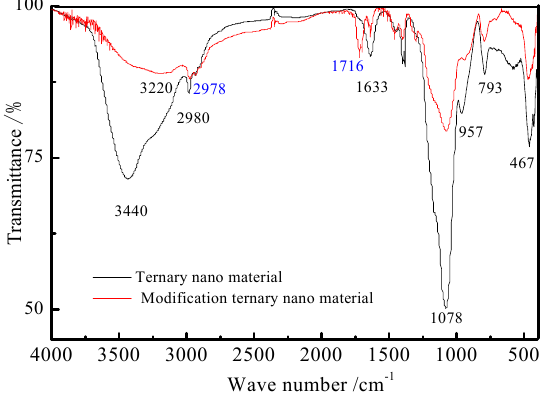
Figure 2. FTIR spectra of the ternary nanomaterials.